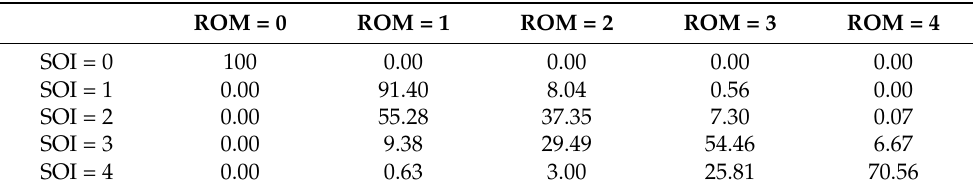
Table 6. Differences between the levels of SOI across the levels of